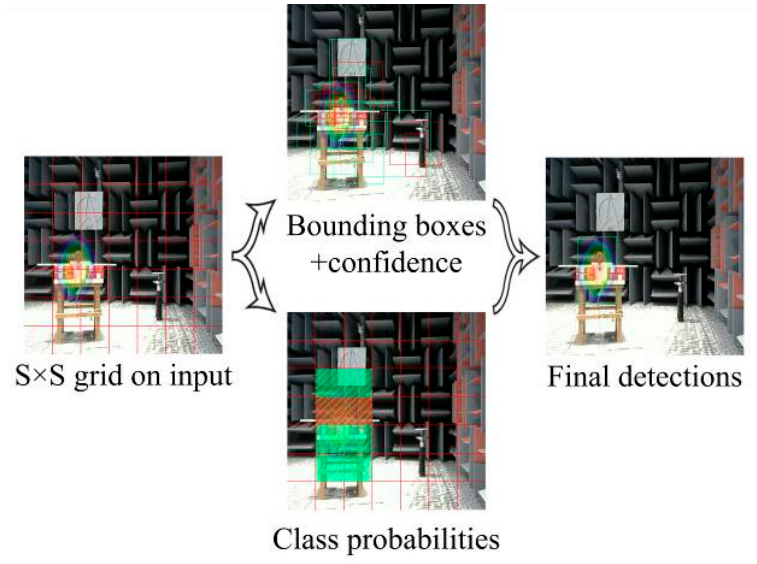
Figure 2. Forecasting process of YOLOv3.